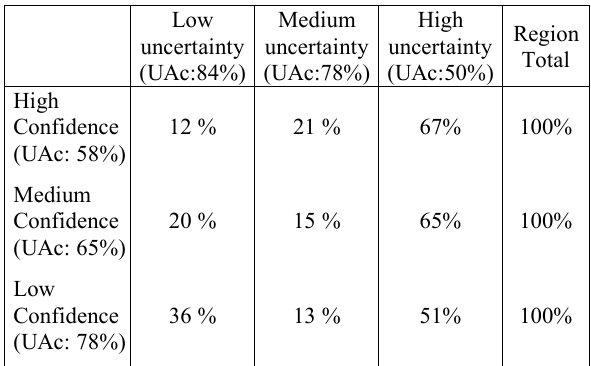
Table 3. Percentage of the pixels classified as Urban Areas with the three levels of confidence that are included in the three levels of uncertainty. UAc represents the User’s accuracy of each region